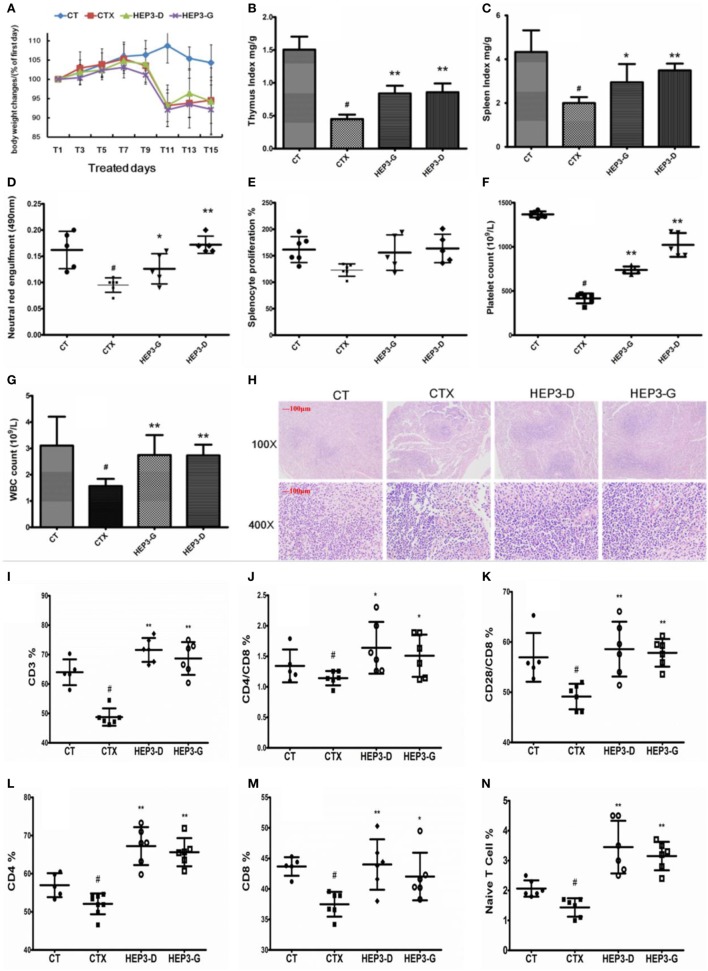
Effect of HEP3 on the cyclophosphamide-induced immunotoxicity mice. Body weight changes (A), thymus index (B), and spleen index (C), neutral red engulfment (D), splenocyte proliferation (E), platelet (F), and white blood cell (G), the tissue structure of the spleen (H), the CD3+
(I), CD4+/CD8 (J), CD4+
(L), CD8+
(M), CD28+/CD8 (K), and naive T cells (N). CT is the control group treated with just vehicle, CTX is the cyclophosphamide-induced group (intraperitoneal injection of 80 mg/kg) group, HEP3-D is the group treated with 100 mg/kg HEP3 and intraperitoneal injection of 80 mg/kg cyclophosphamide, and HEP3-G is the group treated with 200 mg/kg HEP3 and intraperitoneal injection of 80 mg/kg cyclophosphamide. Values were means ± SDs of six independent experiments. #P < 0.05 vs the control group, *P < 0.05, **P < 0.01 vs the CTX, indicating significant differences.